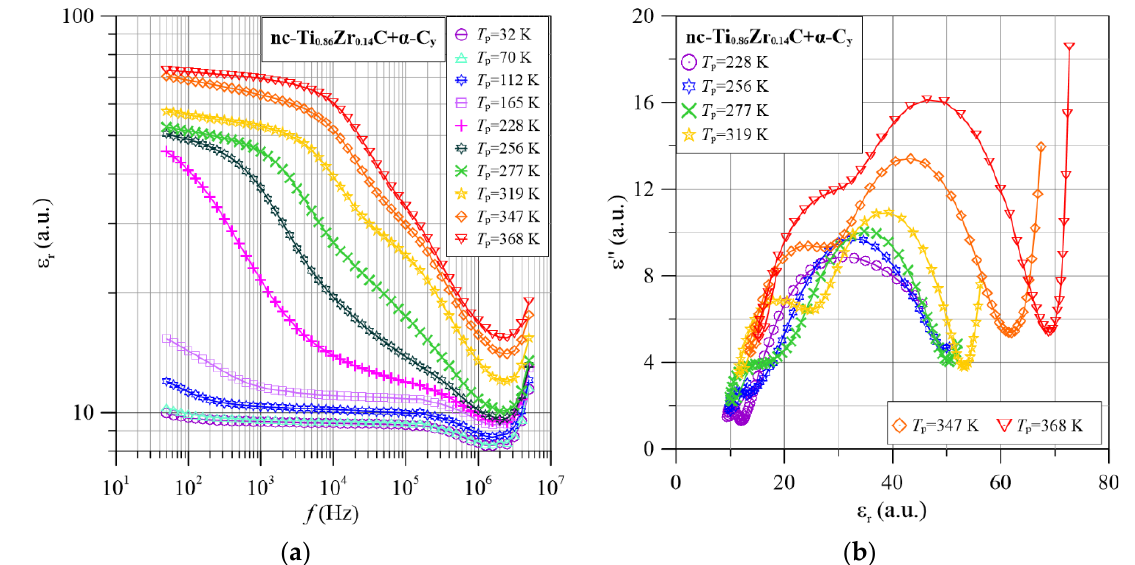
Materials 2022 , 15 , x FOR PEER REVIEW 12 of 17